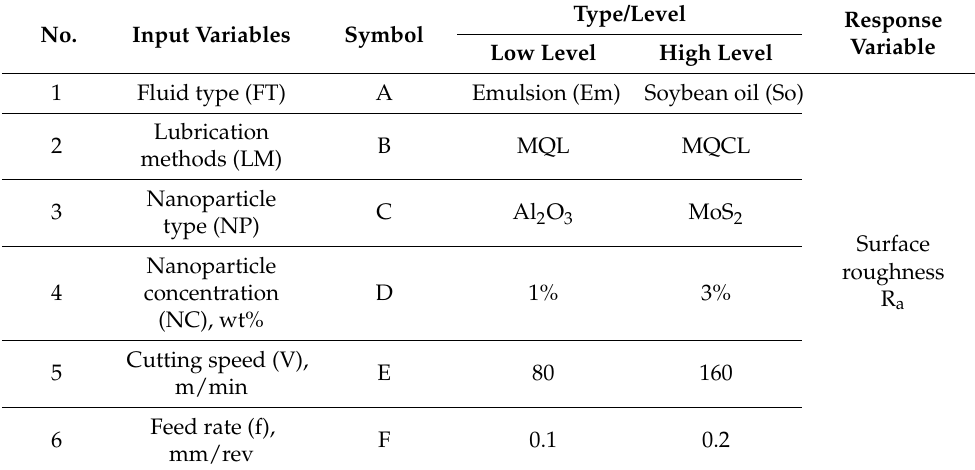
Table 4. Input parameters and their types/levels.